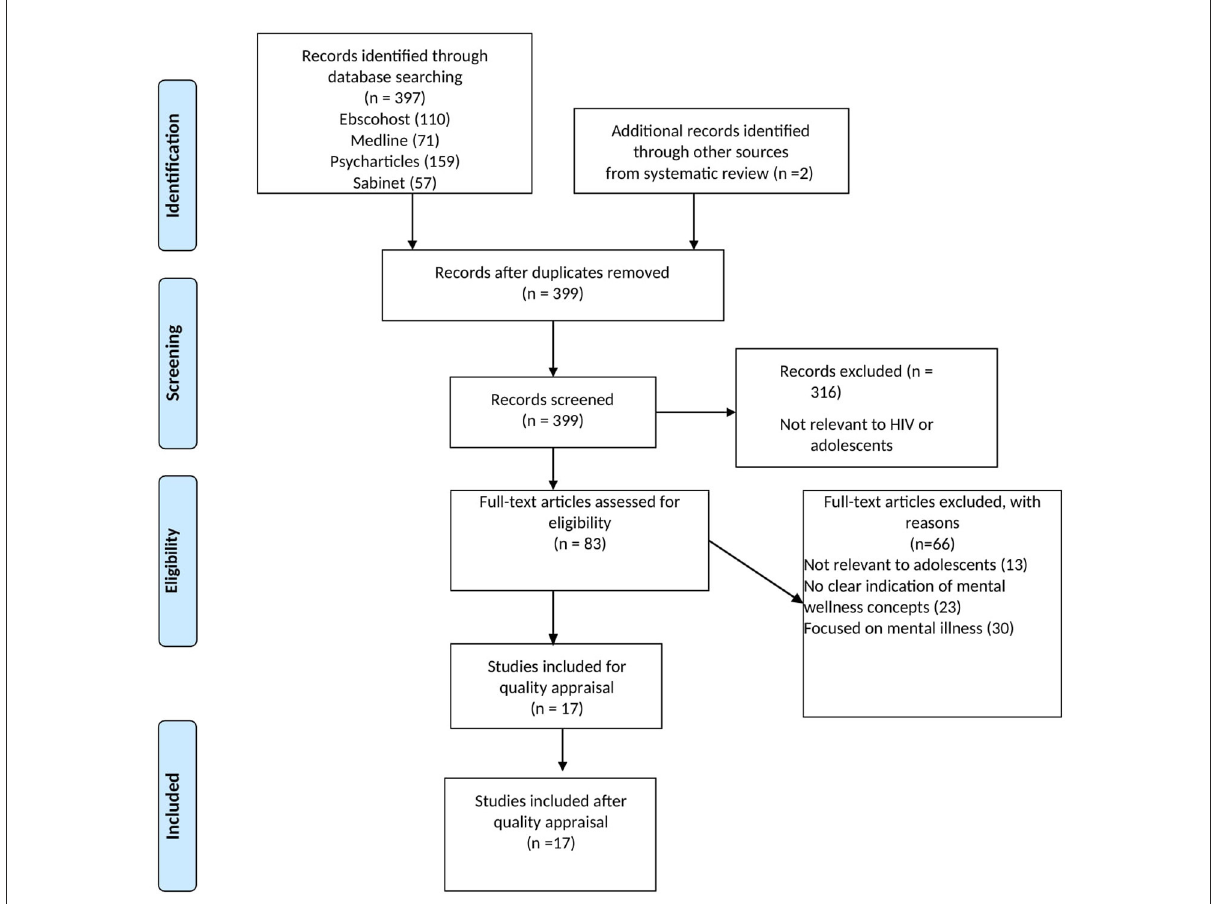
FIGURE1 PRISMA flow diagram of integrative review (Page et al.,